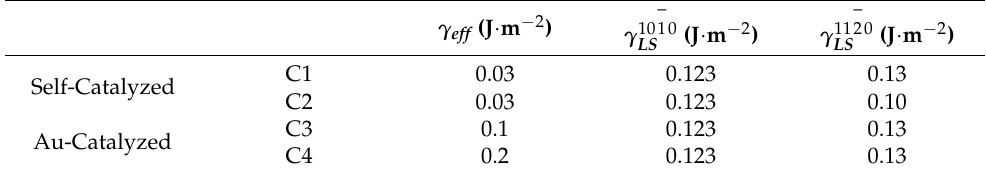
Figure 2. Polygons P m showing the dynamics of ML growth simulated with different sets of surface energies summarized in Table 1. C1 and C2 represent Ga-catalyzed GaAs NW, while C3 and C4 represent Au-catalyzed GaAs NW. The dots represent the nodes of triangular mesh of the NW top facet. This geometry is chosen since it allows us to compute all possible combinations of the inner edge facets of the ML. The {1010} and {1120} facets are marked by green and black lines, respectively. The opaque polygons represent the extending ML. The transparent polygons show the eliminated ML portions, while dashed polygons correspond to the newly formed ML portions. Table 1. Surface energies used for simulations of ML